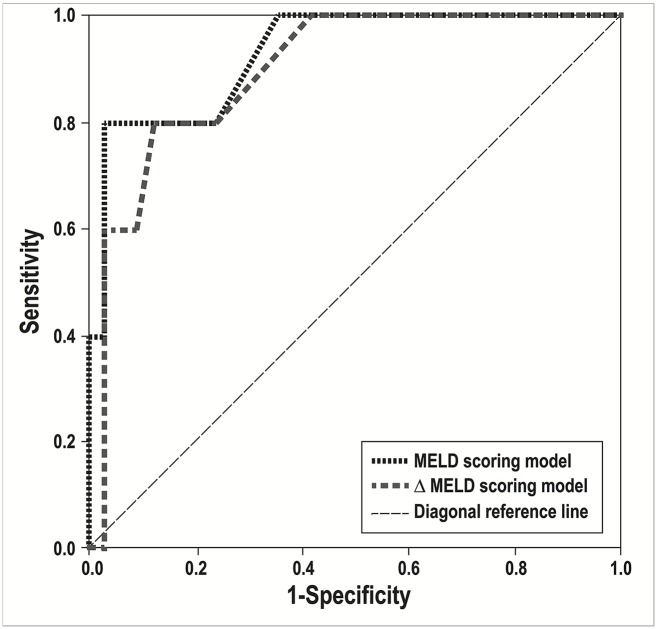
Receiver operating characteristic (ROC) curve for predicting case fatality risk in 39 V. vulnificus-infected patients.The areas under the ROC curve (AOC) of the MELD and ΔMELD are 0.929 (95% CI = 0.818–1.000; p = 0.002) and 0.897 (95% CI = 0.772–1.000; p = 0.005), respectively. The diagonal reference line indicates no discrimination.